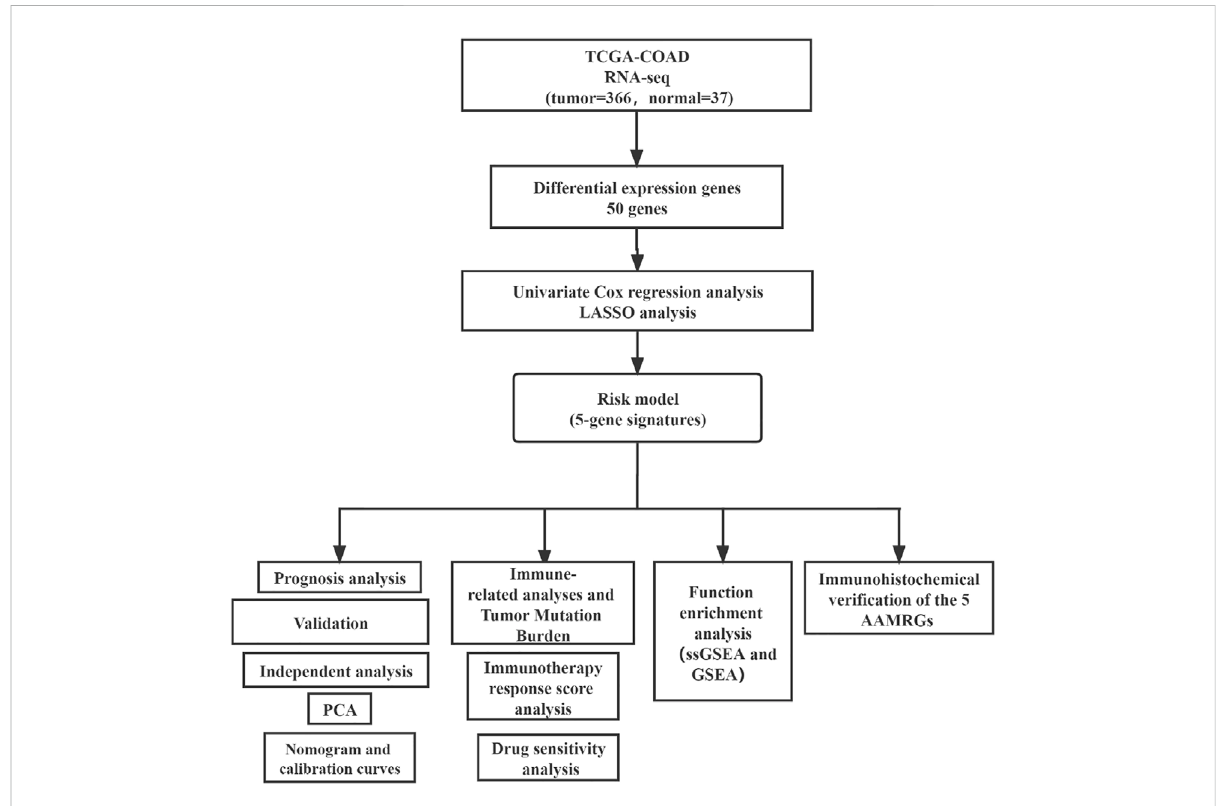
FIGURE 1 Flowchart for analyzing the amino acid metabolism – related genes of